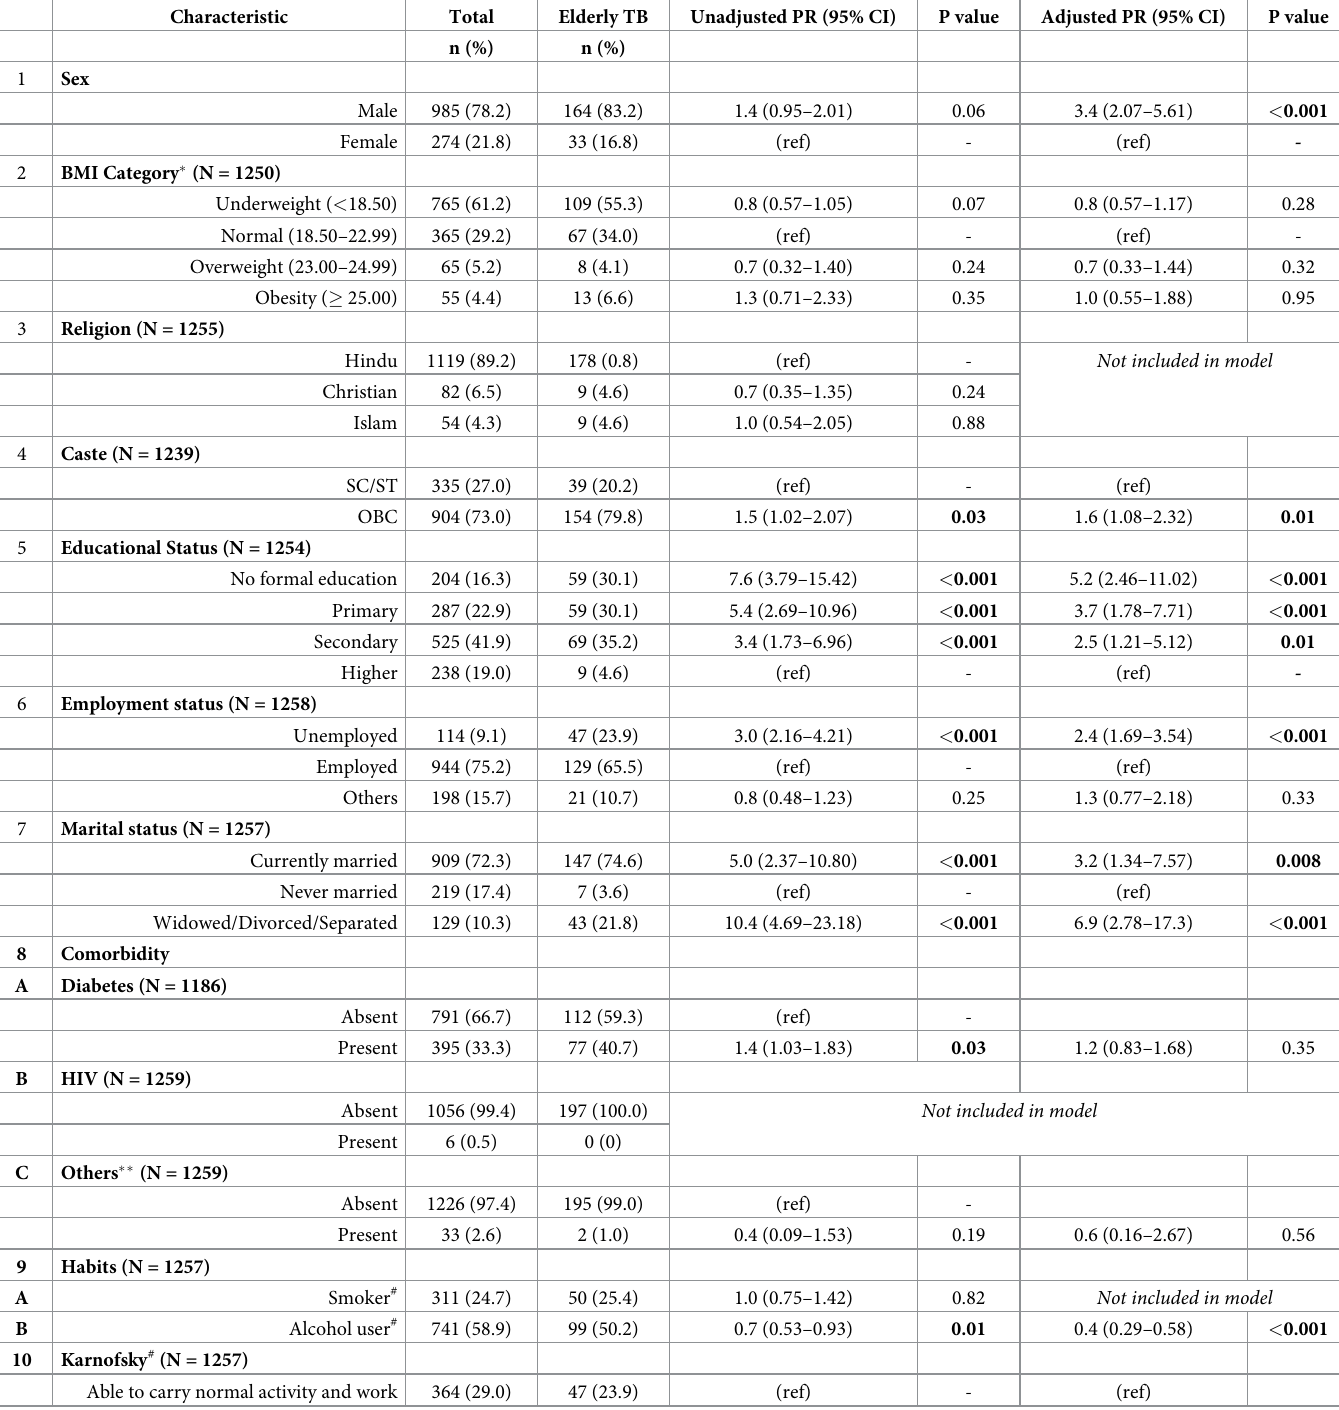
Table 1. Profile of the study participants across the 2 groups—elderly & non-elderly (N =